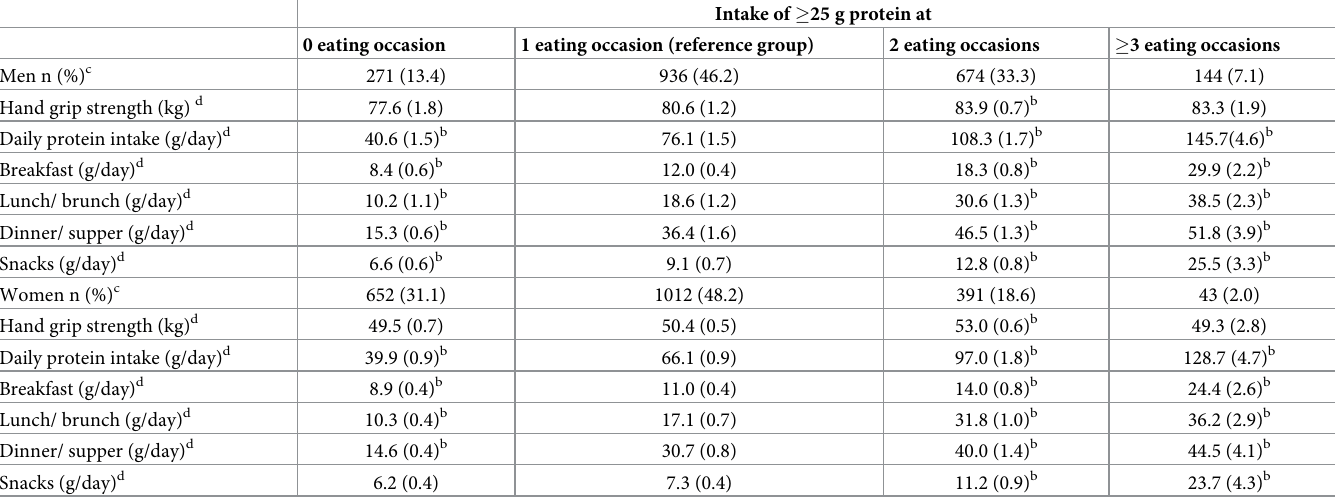
Table 3. Grip strength, daily protein intake, and protein intake at breakfast, lunch, dinner, and snacks by intake of (cid:21) 25g protein at various eating occasions a . Intake of (cid:21) 25 g protein at